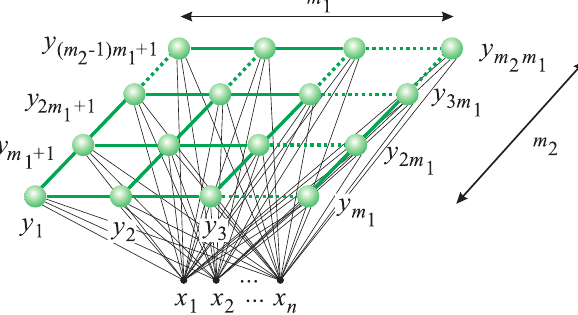
Figure 1. Conventional self-organizing map (SOM) with two-dimensional, rectangular map of